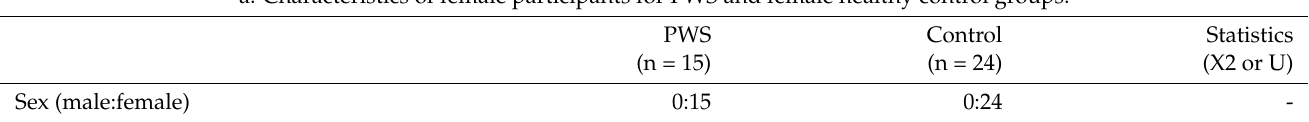
a. Characteristics of female participants for PWS and female healthy control